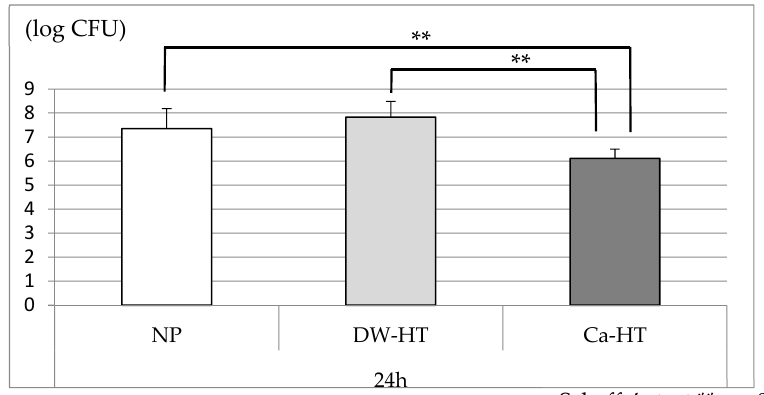
Figure 8. Streptococcus gordonii adhesion onto the substrata after 24 h of inoculation. The number of bacteria on Ca-HT was significantly lower than in the other two groups ( p < 0.01). CFU: colony forming unit.